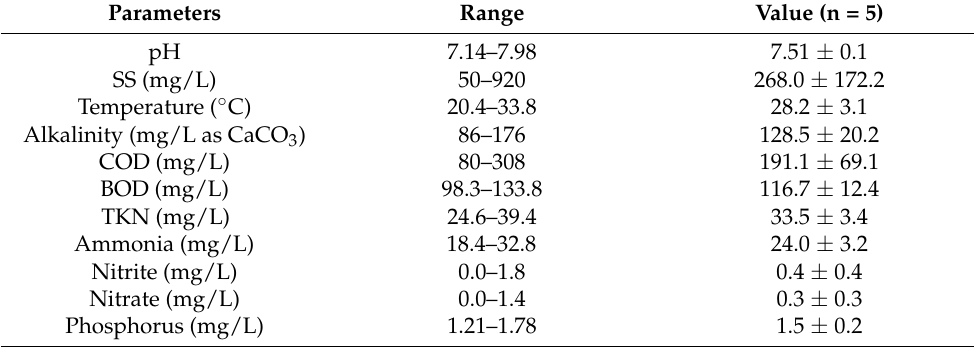
Table 1. Domestic wastewater